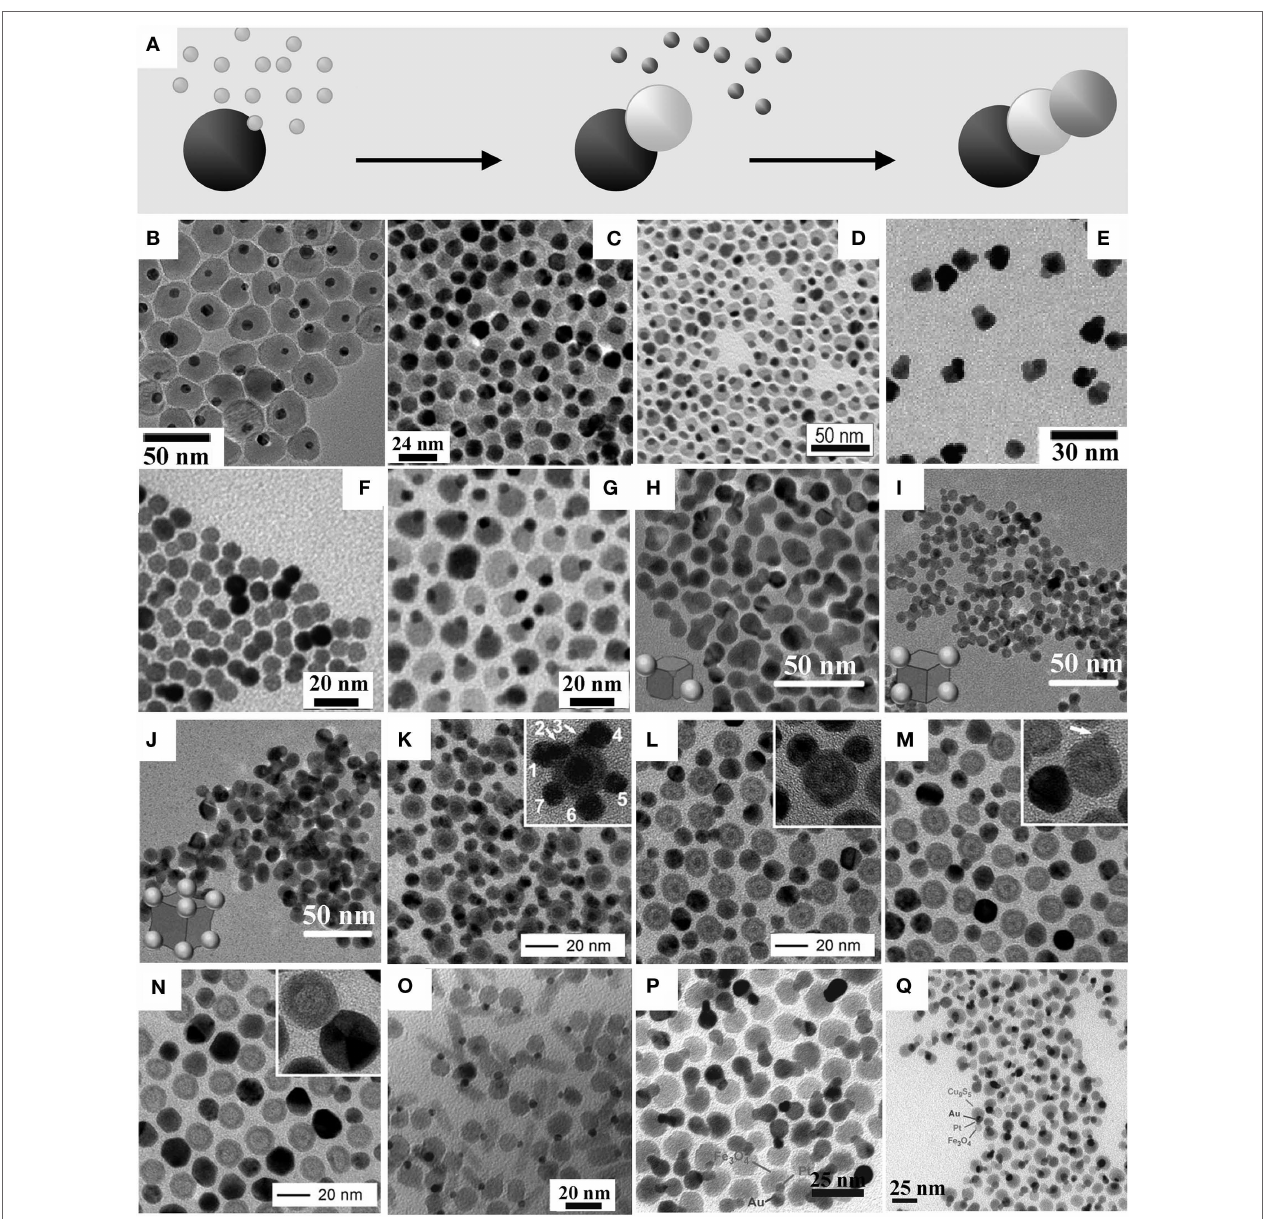
FIGURE 2 | Examples of hetero-dimers and hetero-trimer magnetic heterostructured nanocrystals (MHNCs) synthesized by direct epitaxial heterogeneous nucleation onto preformed seeds . ( A ) sketch of the mechanism [adapted from Casavola et al. (2008) with permission, copyright Wiley-VCH Verlag GmbH & Co. KGaA]. (B–Q) Low-magnification transmission electron microscopy images of: (B) peanut-shaped Au–MnO MHNCs [adapted from Choi et al. (2008) with permission, copyright American Chemical Society]; (C) dumbbell-like Au–Fe 3 O 4 MHNCs [reproduced from Yu et al. (2005) with permission, copyright American Chemical Society]; (D) peanut-shaped FePt–In 2 O 3 hetero-dimer MHNCs with cubic-shaped FePt domains [reproduced from Wu et al. (2011a) with permission, copyright American Chemical Society]; (E) FePt–Au hetero-dimer MHNCs made of cubic-shaped FePt and spherical-shaped Au domains [reproduced from Choi et al. (2006) with permission, copyright American Chemical Society]; (F) symmetric CoPt 3 –Au hetero-dimer MHNCs synthesized according to Pellegrino et al. (2006); (G) peanut-shaped Pt–Fe 3 O 4 MHNCs [adapted from Wang et al. (2010) with permission, copyright American Chemical Society]; (H–J) trimeric and oligomeric FePt–Au heterostructured nanocrystals grown starting from cubic FePt seeds [reproduced from Zhu et al. (2013) with permission from The Royal Society of Chemistry]; (K–N) evolution from Fe@Fe x O y –Ag hetero-oligormer MHNCs to lower-order hollow-Fe@Fe x O y –Ag hetero-oligormers to hollow-Fe x O y –Ag hetero-dimers via ripening and Kirkendall diffusion [reproduced with permission from Peng et al. (2011), copyright Wiley-VCH Verlag GmbH & Co. KGaA]; (O) Au–Fe 3 O 4 –PbS hetero-trimer MHNCs obtained by nucleating a rod-shaped PbS section on the Au domain of Au–Fe 3 O 4 hetero-dimer seeds [reproduced from Shi et al. (2006b)